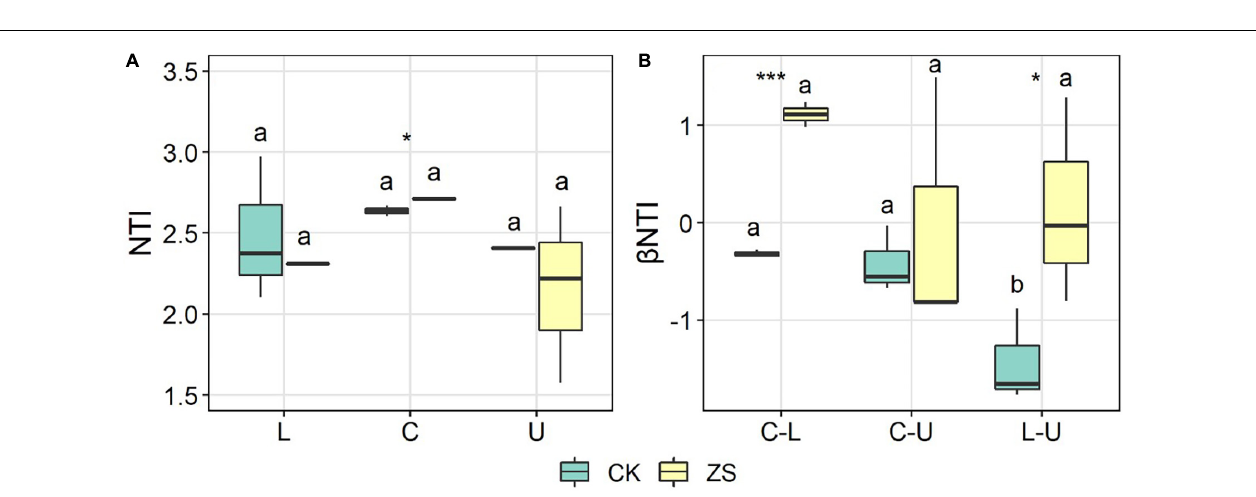
FIGURE 6 | Nearest taxon index (NTI) (A) and β nearest taxon index ( β NTI) (B) of endophytic fungal community in the lower (L), center (C), and upper (U) leaves of ordinary (CK) and “cherry-red” (ZS) tobacco. Asterisks indicate significant differences between CK and ZS, while different lettters above the boxes indicate significant differences between plant sections. * p < 0.05; *** p <